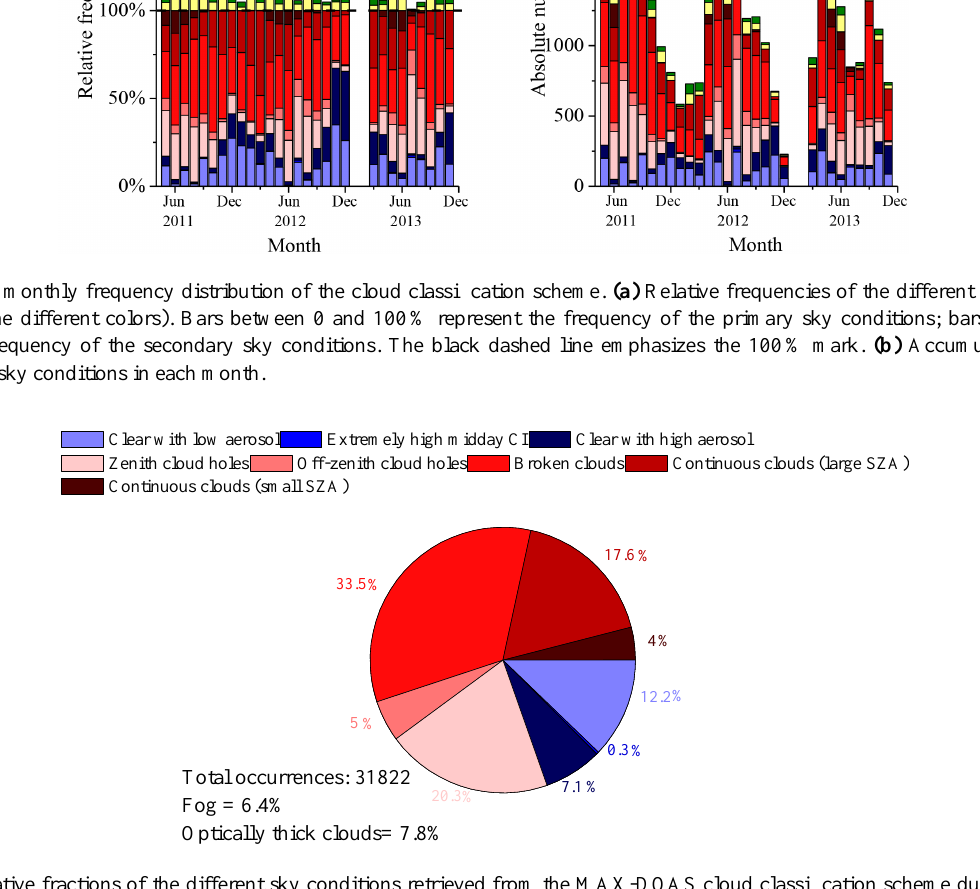
Figure 11. Relative fractions of the different sky conditions retrieved from the MAX-DOAS cloud classification scheme during the whole measurement